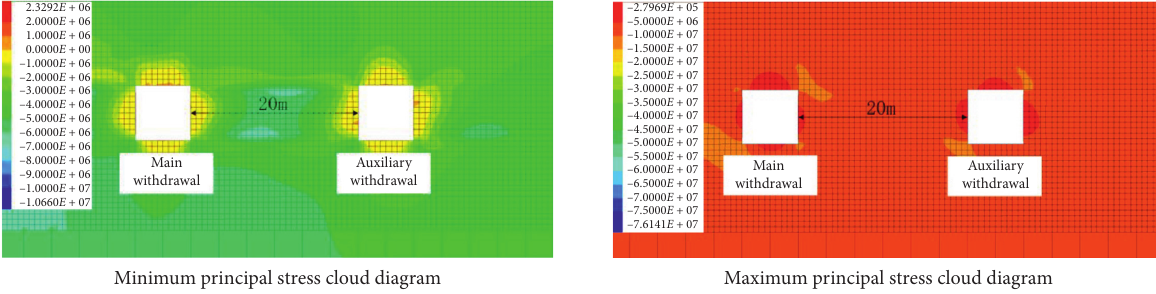
Figure 9: Principal stress cloud diagrams when Panel 31113 was 50m from penetration. (a) Main and auxiliary withdrawal spacing � 30m. (b) Main and auxiliary withdrawal spacing � 25 m. (c) Main and auxiliary withdrawal spacing �